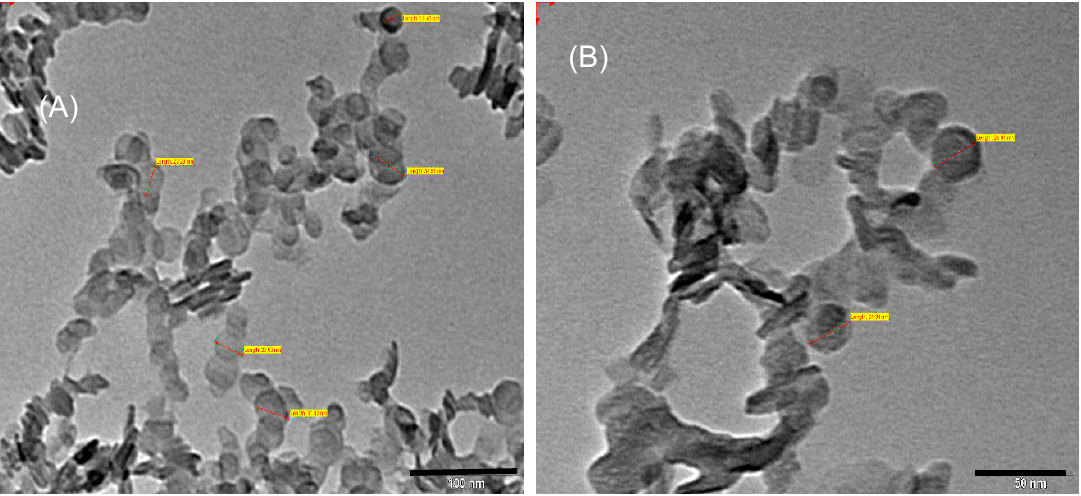
Figure 10. TEM images of ( A ) BCA-LDH-I and ( B ) BCA-LDH-C.